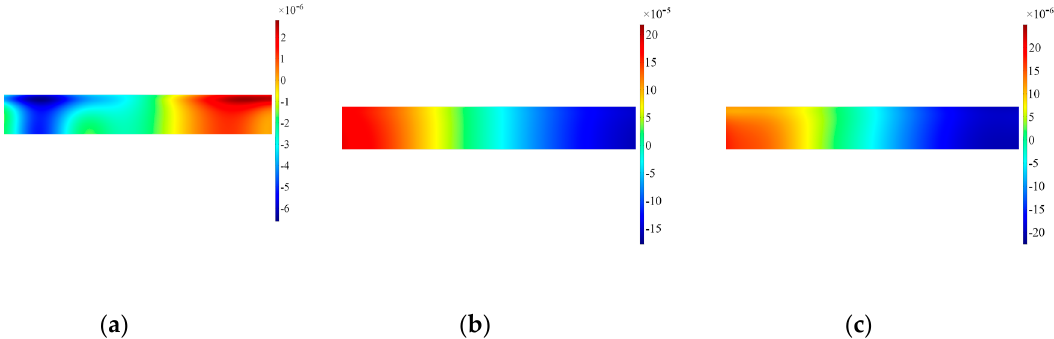
Figure 16. Surface plot for in-of-plane velocity on the alumina wear-plate, Configuration A’. Note that data are plotted at timeframes of 100 μ s ( a ), 300 μ s ( b ) and 500 μ s ( c ).